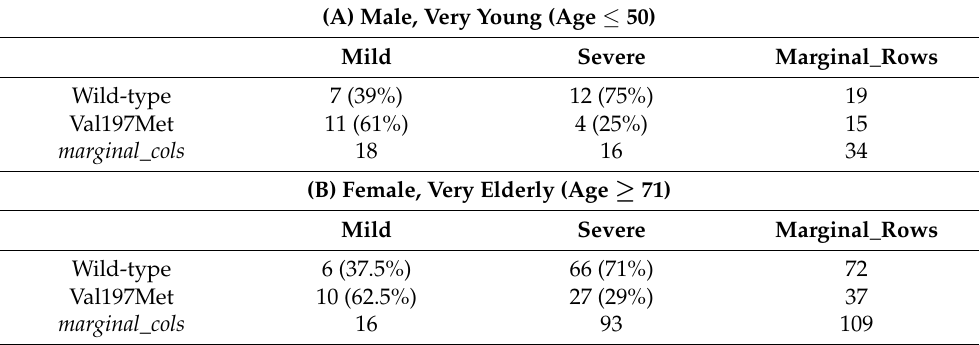
Table 4. Contingency tables of V197M TMPRSS2 in very young males and very elderly women affected by